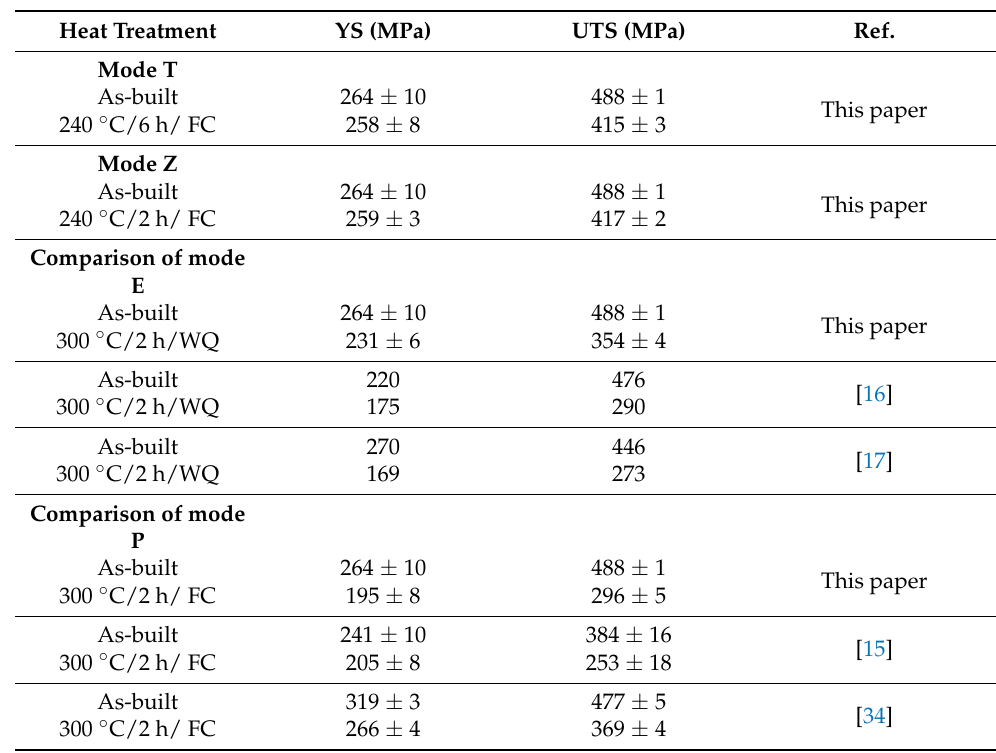
Table 7. Comparison of mechanical properties of L-PBF AlSi10Mg after annealing at T, Z, E, and P modes; results of this work compared to the same annealing modes in the available literature. Heat Treatment YS (MPa) UTS (MPa)